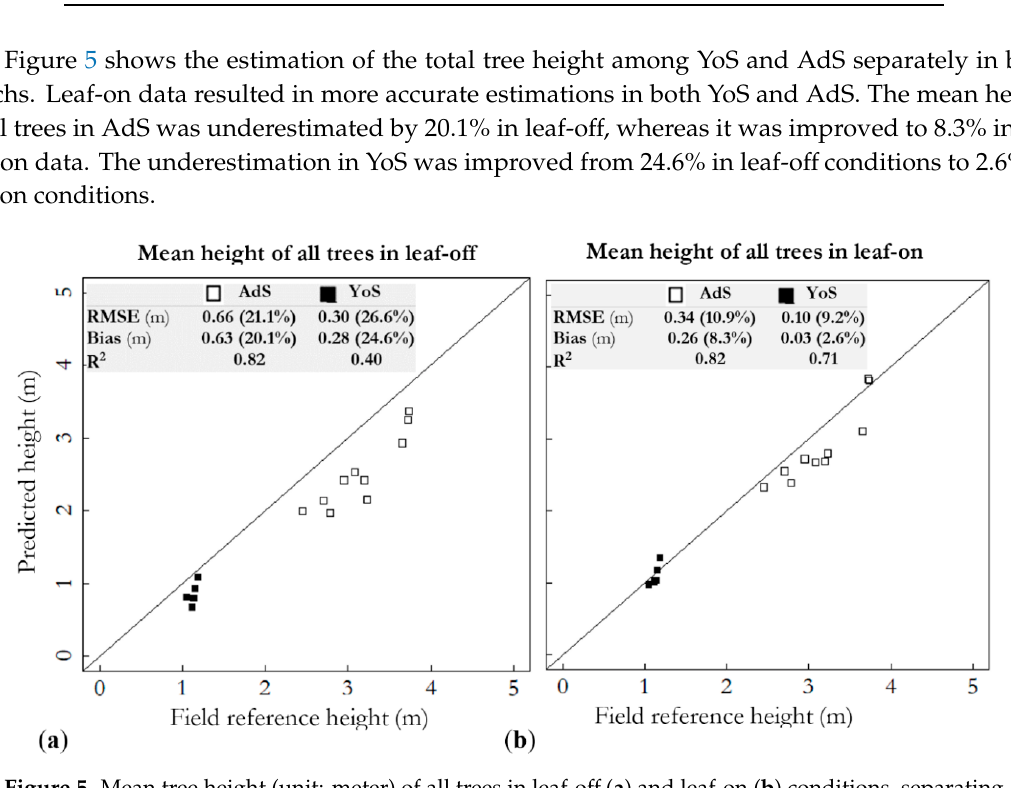
Figure 5. Mean tree height (unit: meter) of all trees in leaf-off ( a ) and leaf-on ( b ) conditions, separating plots in advanced seedling stand (AdS) and plots in young seedling stand (YoS). The mean height of spruces was underestimated by 19.4% and 8.7% (relative RMSE of 19.8% and 10.8%) in the AdS in leaf-off and leaf-on conditions, respectively (Figure 6). Although it was underestimated by 24.6% (relative RMSE of 26.4%) for the YoS in leaf-off conditions; it was overestimated by 2.4% in leaf-on conditions (relative RMSE of 9.6%). The overestimation (Figure 6b) could be due to higher underestimation of spruce tree density in leaf-on (Figure 4b), which could show the omission of small spruce trees and result in the 2.4% overestimation. Relative RMSE for AdS (10.8%) was larger than YoS (9.6%) in leaf-on, in contrast to leaf-off conditions.